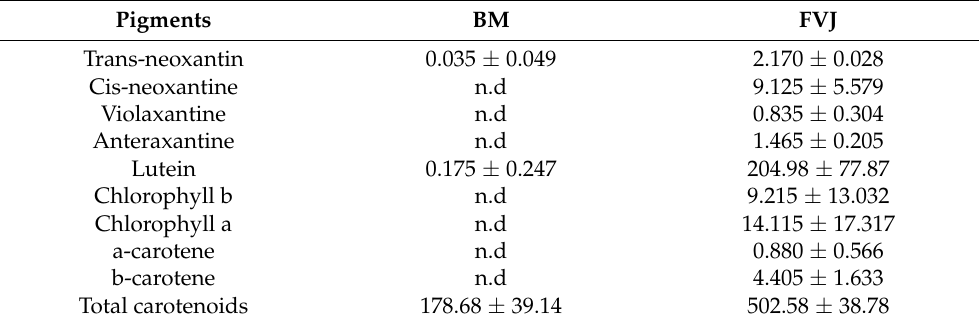
Table 10. Pigments ( µ g g DM − 1 ) obtained in the residual pellets obtained after protein extraction. Pigments BM FVJ Trans-neoxantin 0.035 ± 0.049 2.170 ± 0.028 Cis-neoxantine n.d 9.125 ± 5.579 Violaxantine n.d 0.835 ± 0.304 Anteraxantine n.d 1.465 ± 0.205 Lutein 0.175 ±